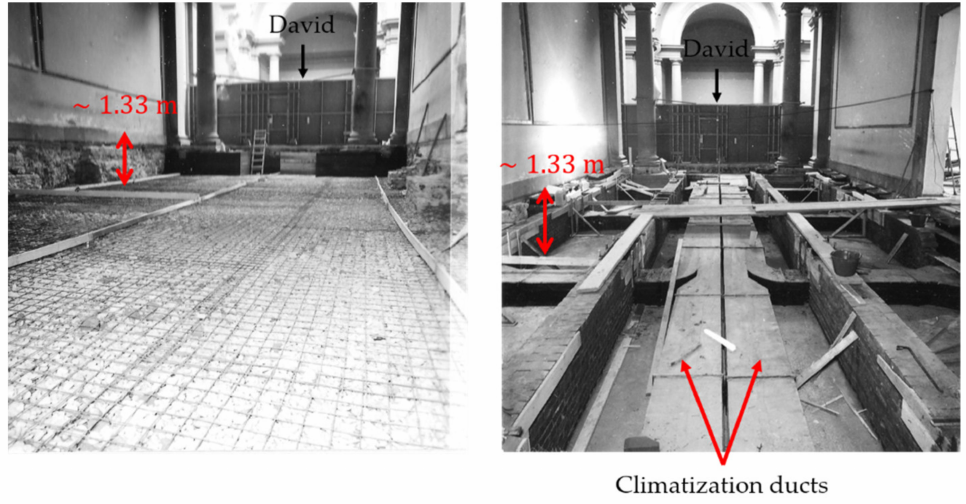
Figure 4. Original pictures from renovation work in the 1980s taken in the “Galleria dei Prigioni”.